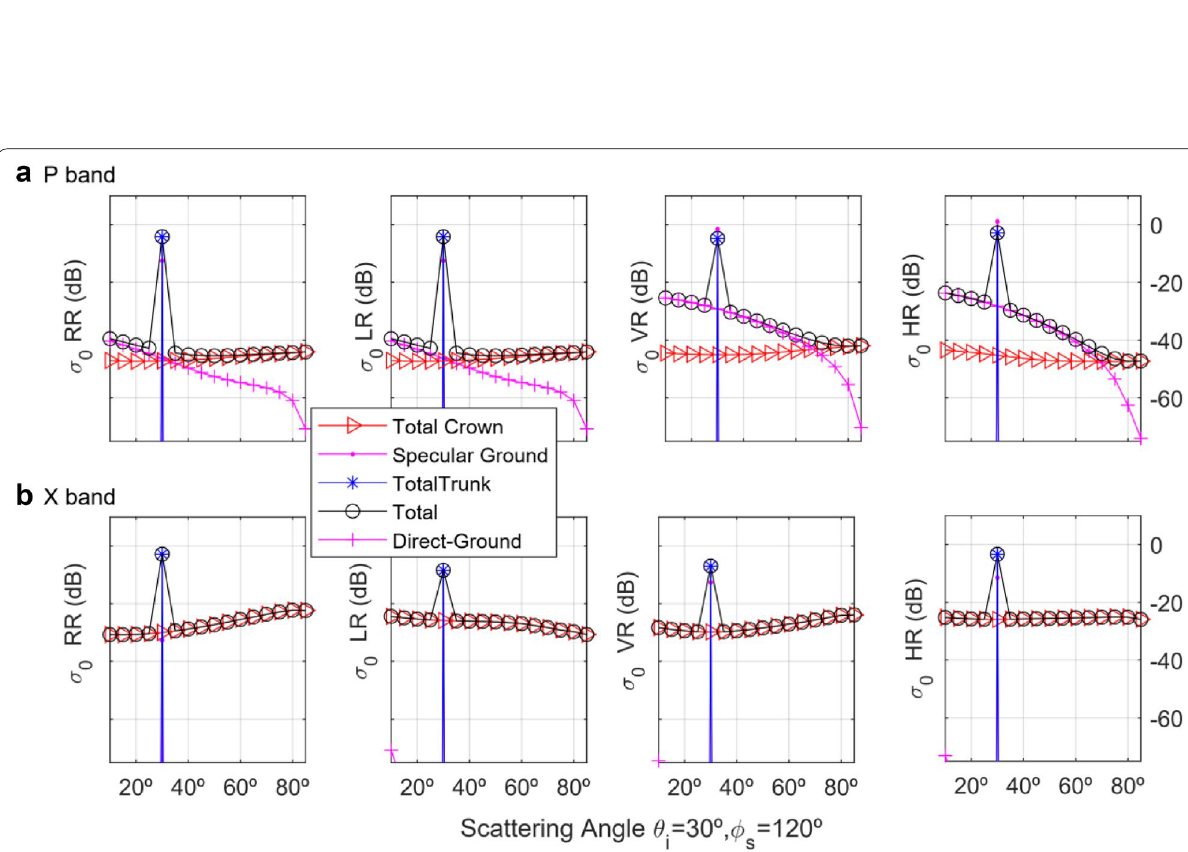
30°, ϕ s 120° for various = =